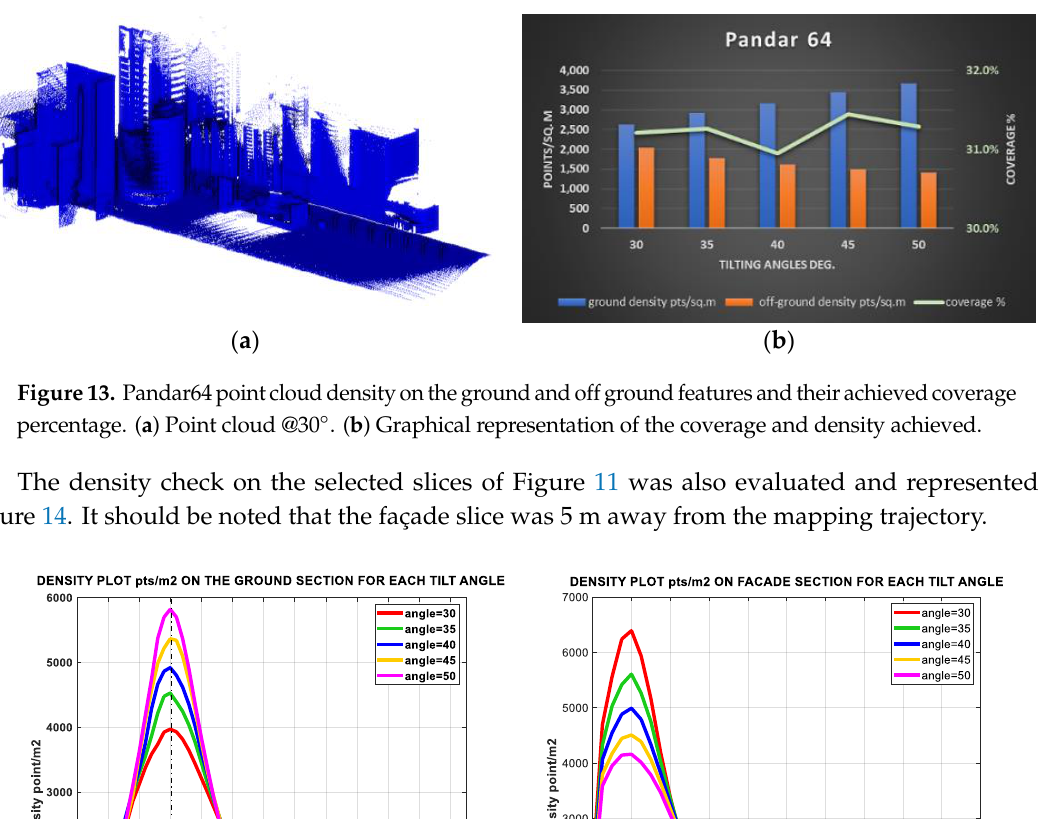
ground section. ( b ) Density computed on the facade section.